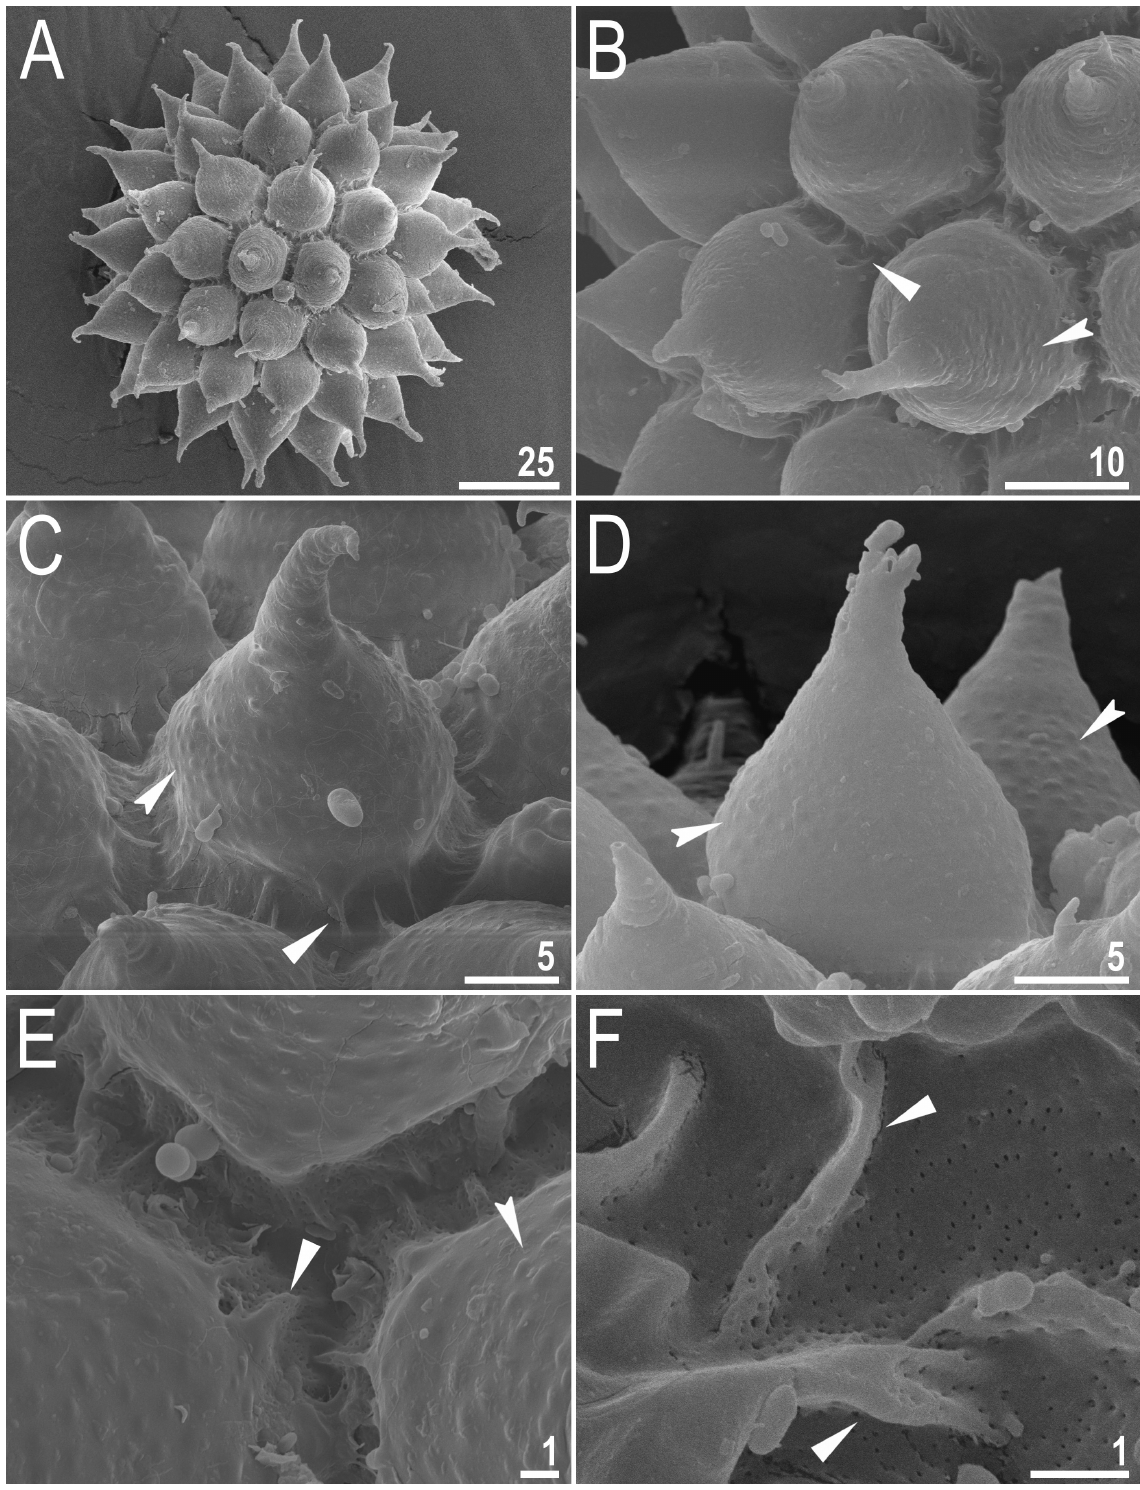
Fig. 19. Tenuibiotus zandrae sp. nov. Egg chorion morphology seen in SEM. A . Entire egg. B . Magnification of the egg surface. C – F . Details of the egg processes and surface between them. Filled flat arrowheads indicate thickenings/striae on the surface between processes and filled indented arrowheads indicate small tubercles on the process walls. Scale bars in